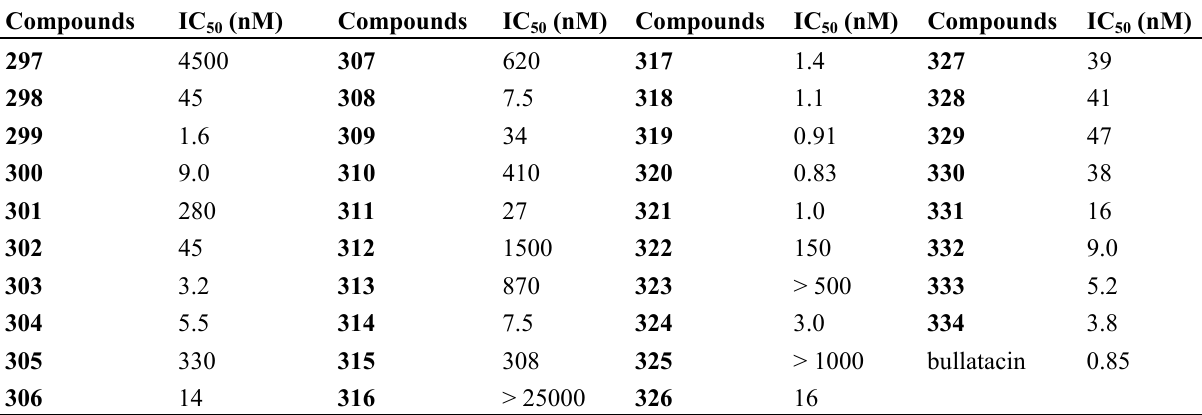
Table 24. Summary of the inhibitory potencies against complex